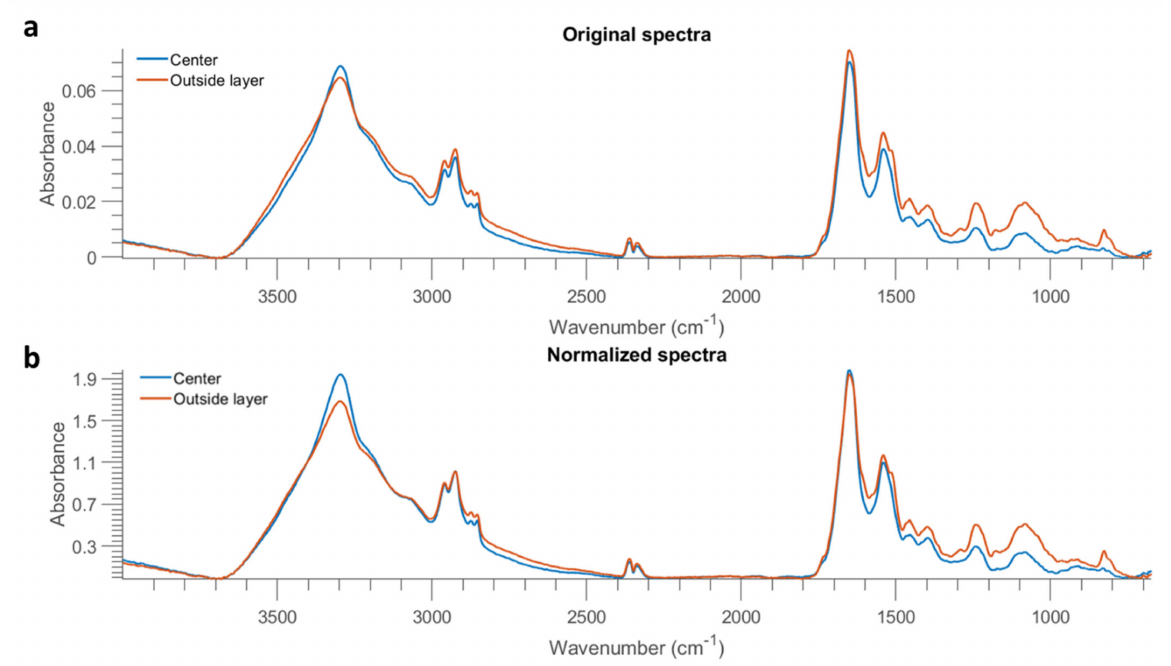
Figure 10. Mean spectra of the centre part and outside layer of one E. coli sample at 10 OD from Al (after removing baseline using asymmetric least squares smoothing) ( a ), as well as the result after normalization by dividing the intensity at 2926 cm − 1 ( b